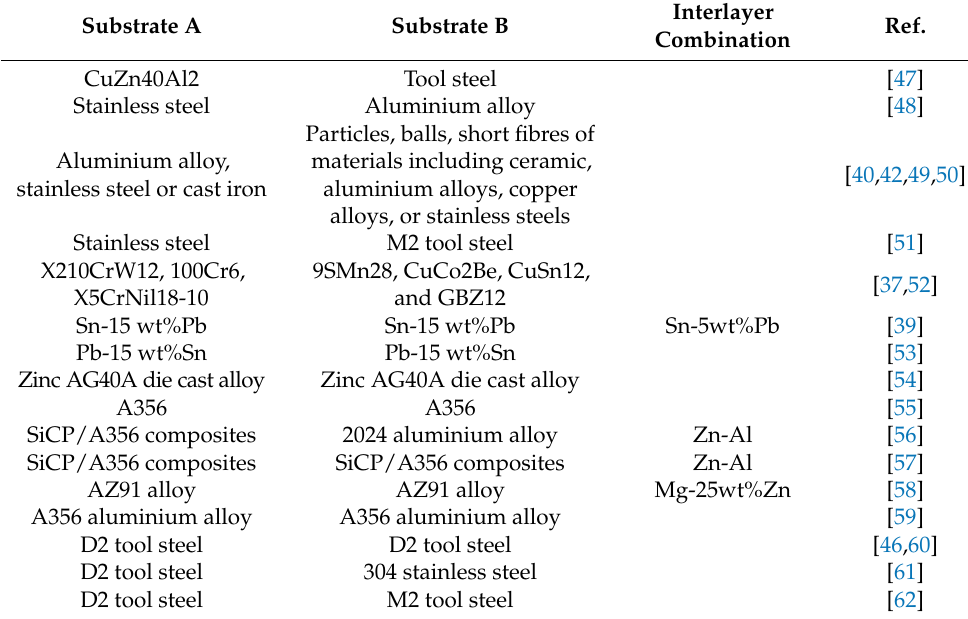
Table 1. Types of materials joined by semi-solid metal joining